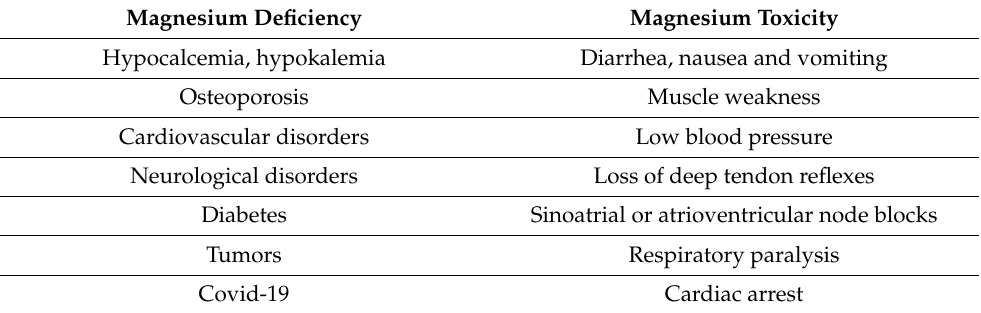
Table 4. Diseases associated with magnesium deficiency and